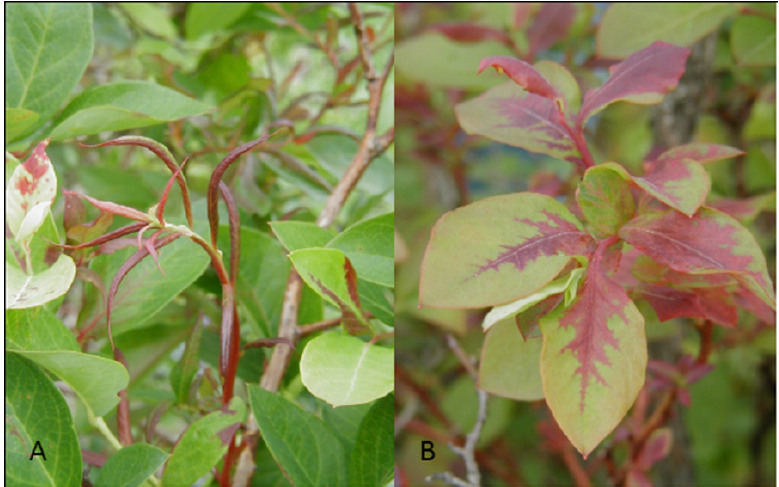
Figure 5. Blueberry shoestring virus symptoms: ( A ) Narrow strapped leaves that may be reddish in color, note not all leaves exhibit symptoms; and ( B ) Oakleaf pattern of reddening on normal shaped leaves (Photos courtesy Mark Longstroth Michigan State